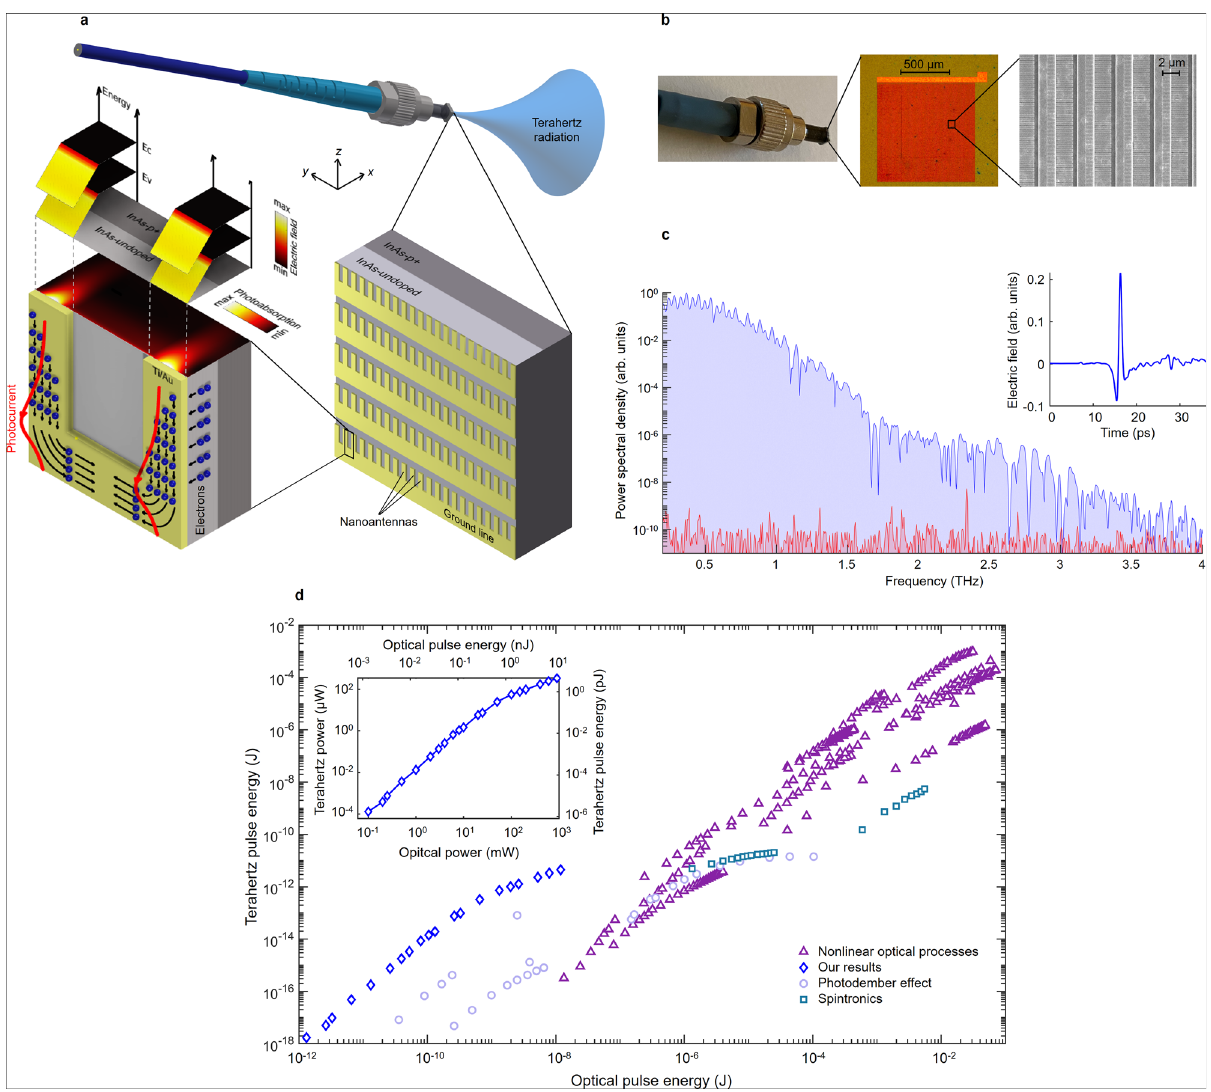
Fig. 2 Wavelength conversion through plasmon-coupled surface states. a Schematic of a nanoantenna array on an InAs semiconductor substrate, which is designed to couple photo-excited surface plasmons to the surface states where a built-in electric fi eld drifts the photo-induced electron gas to the nanoantennas to generate radiation at the optical beat frequencies. The nanoantenna geometry and semiconductor structure are chosen to maximize the spatial overlap between the built-in electric fi eld and photoabsorption pro fi les. Three-dimensional computer aided design (CAD) drawing of the fi ber connector (item no: 30125D2) provided as compliments by Thorlabs, Inc. b Photograph, microscopy, and scanning electron microscopy images of